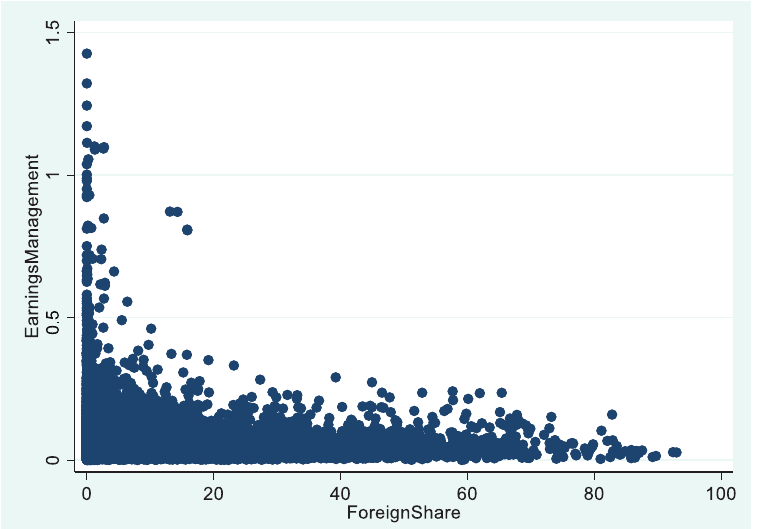
Figure 1. Scatterplot of